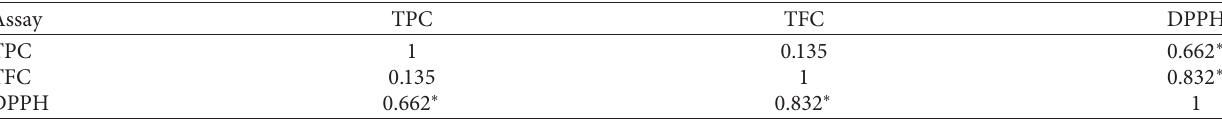
∗ Correlation is significant at p ≤ 0 .